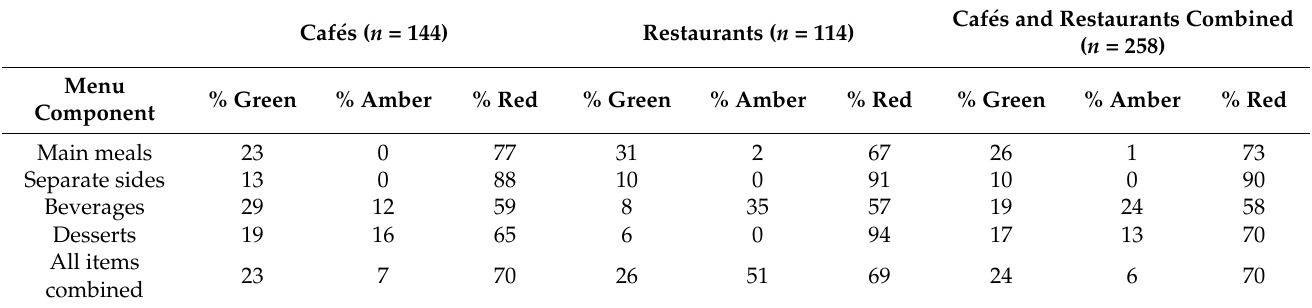
Table 3. Kids’ Menu items categorized by the Traffic Light System of food